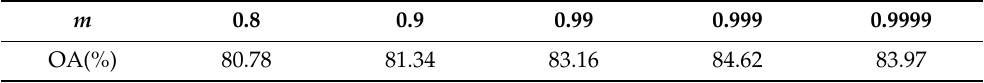
Table 5. The OA with a different momentum